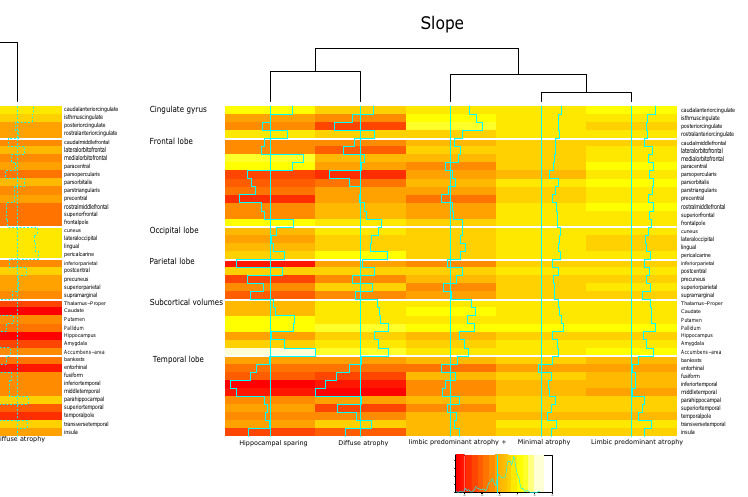
Fig. 4 | Longitudinal clustering model cluster-mean intercept and slope atro- phycoef fi cients. Eachrowoftheheatmapisgroupedintermsofneuroanatomical spatialposition(redcolor;moreatrophy,yellowcolor;lessatrophy).Columnsthat represent different clusters are grouped in terms of similarity between clusters. Vertical lines within cells represent cluster region mean ROI value (the vertical